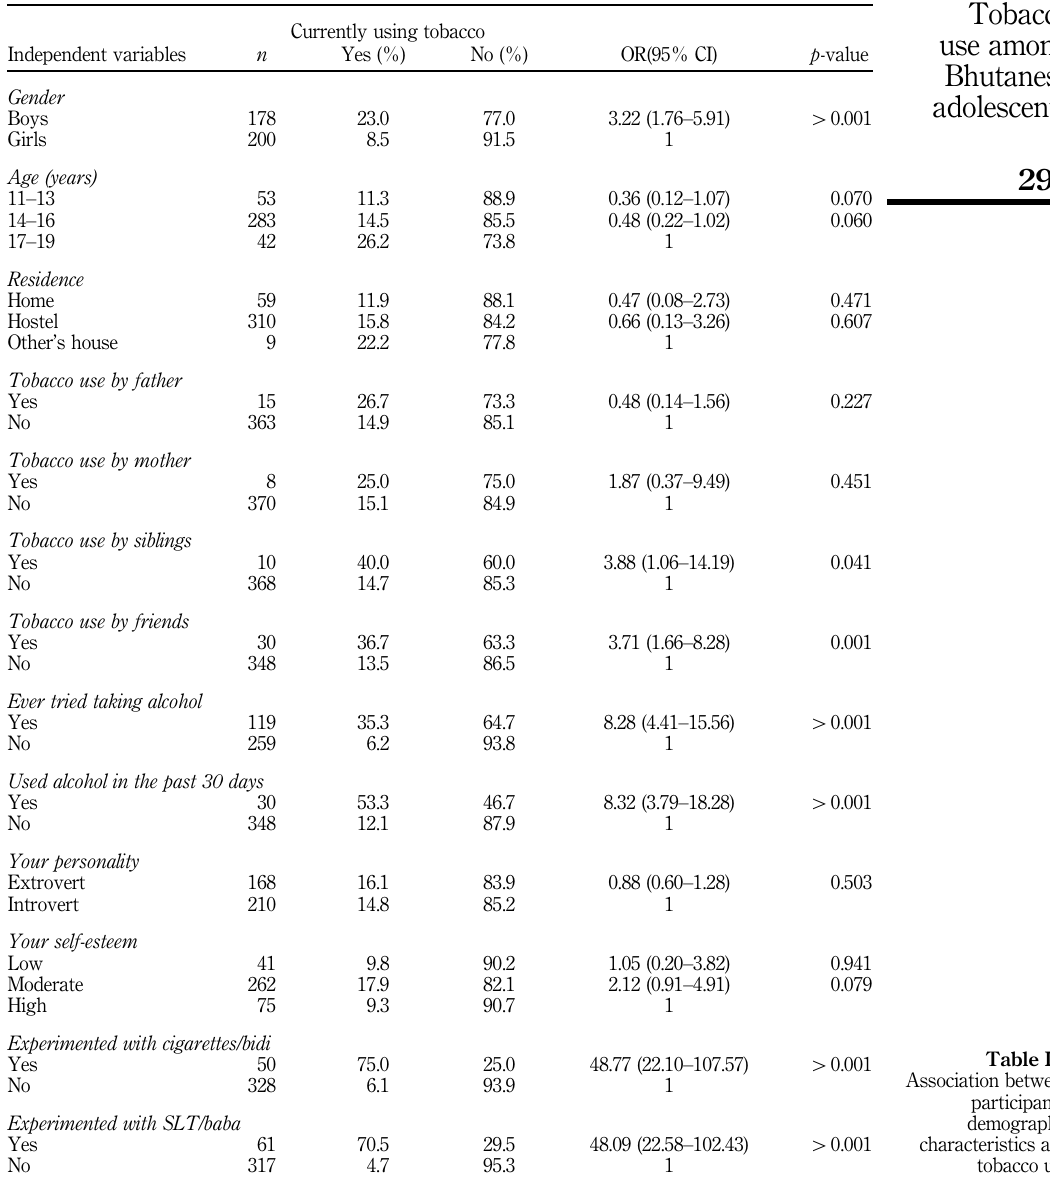
Table III. Association